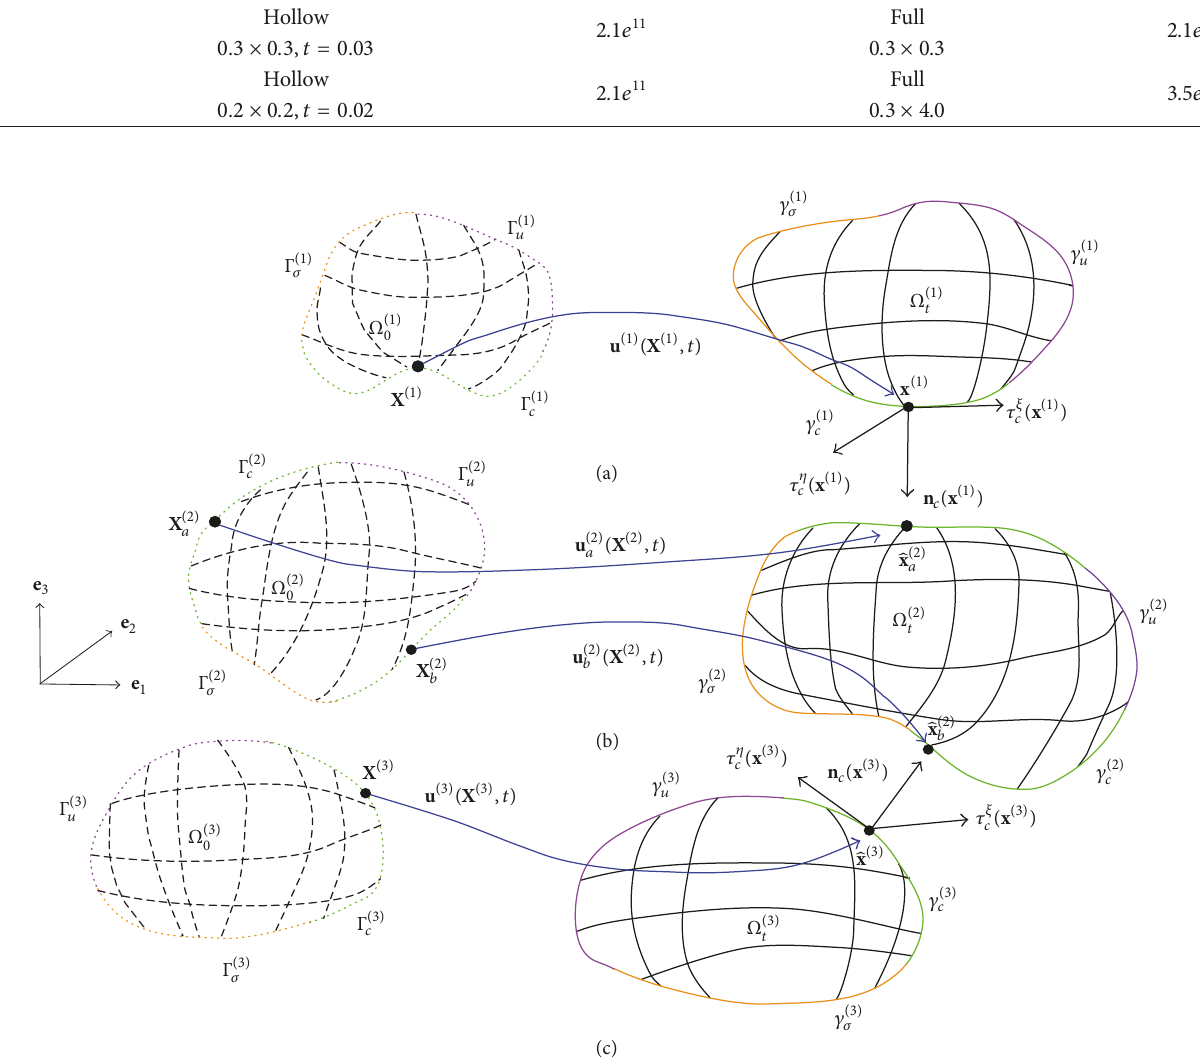
Figure 2. Different cross sections as well as different stiffness parameters are chosen for the columns and beams. The meas- are presented in Table